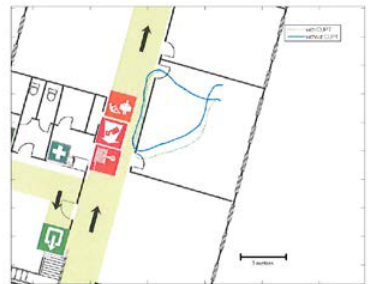
Figure 6: Estimated trajectory of the IMU post-calibration with and without applying loop-closure After - with After - without Before CUPT